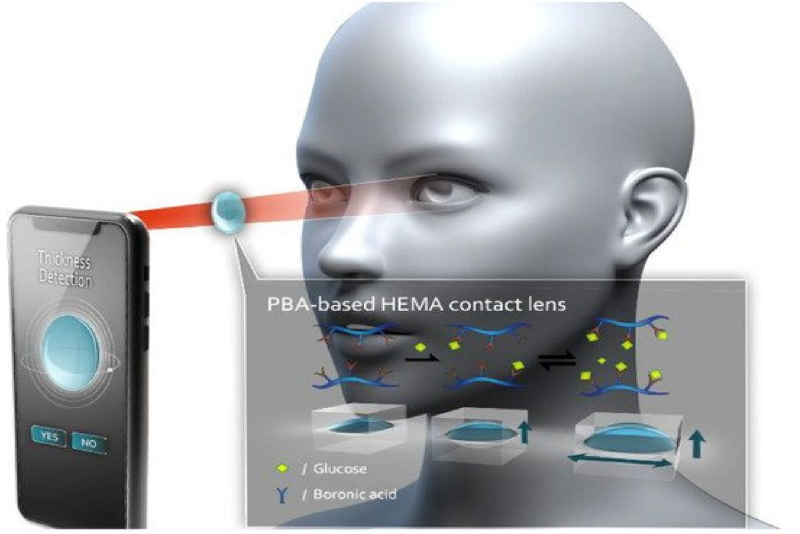
Figure 5. Tear-based wearable biosensors 72